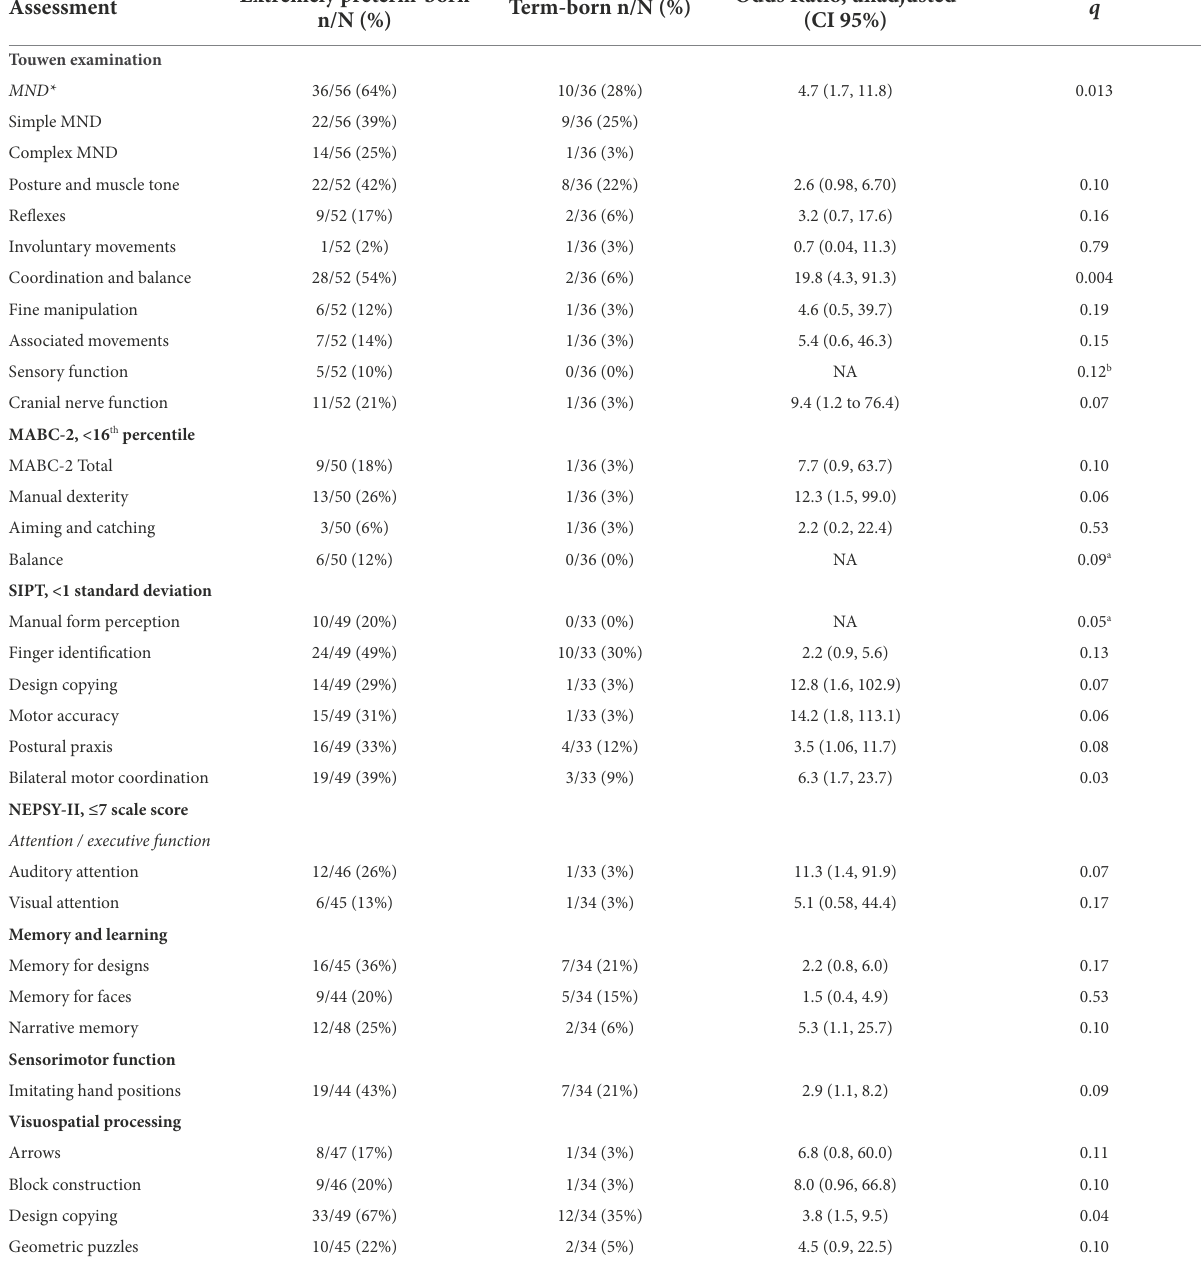
TABLE 2 Rates of impairments in the Touwen neurological examination, MABC-2, SIPT and NEPSY-II.